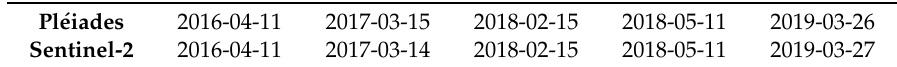
Table 1. Dates of the Pl é iades and Sentinel-2 dataset pairs to calibrate and validate the NDSI–FSC relationship (dates are given in format year-month-day).